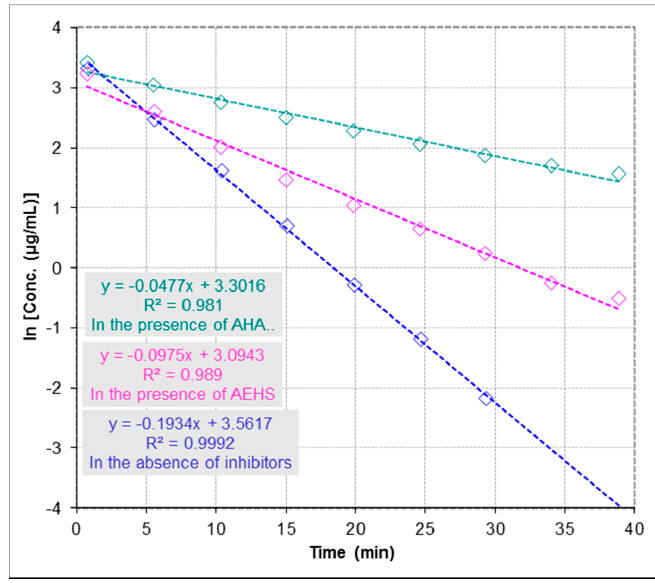
Figure 4. Effect of aqueous extract of Hibiscus sabdariffa (AEHS) and acetohydroxamic acid (AHA) on the inhibition of urease activity by Electrospray Ionization-Mass Spectrometry (ESI-MS) based assay. Urease activity and inhibitory properties of AHA and AEHS were assayed as described in Experimental section, where k is the reaction rate constant in the presence of AHA [ ● ] and AEHS [ ● ] (k = 0.0477 and 0.0975 min − 1 , respectively) and k 0 is the reaction rate constant in the absence of inhibitors [ ● ] (k 0 = 0.1934 min − 1 ). Concentrations changes of urea are presented as logarithms of concentration. IC 50 for AEHS was determined to be 82.4 µg ∙ mL − 1 and for AHA to be 4.3 µmol ∙ L − 1 . The precision of time course analysis was calculated as RSD (%) of multiple measured slopes (lower than 10%). For clarity of figure, multiple measurements have not been presented.